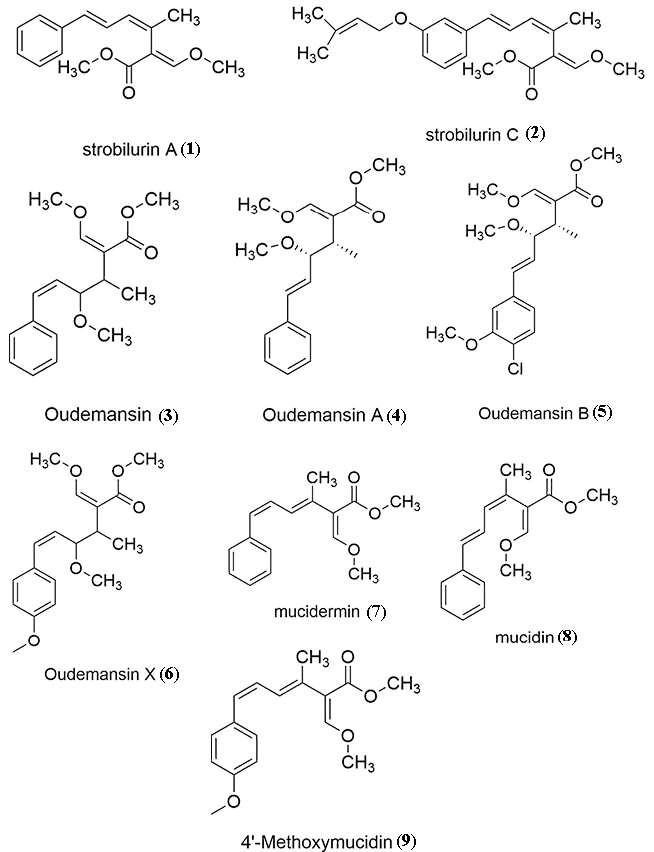
Figure 5. Chemical structures of bioactive compounds isolated from OX genera with antimicro- bial/antifungal activities.